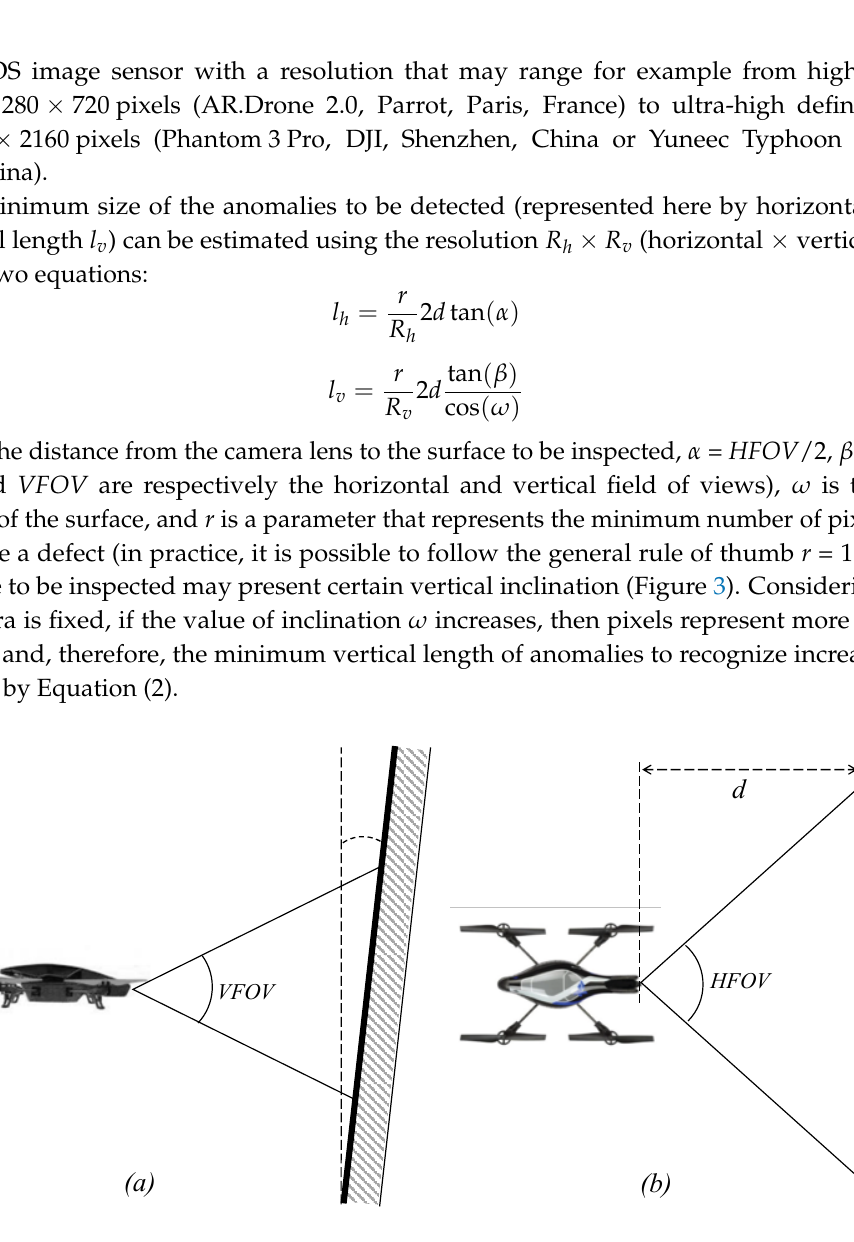
Figure 3. Location of the air vehicle with respect to the surface. The figure shows the vertical field of view VFOV of the camera ( a ), the horizontal field of view HFOV ( b ), vertical surface inclination ω and distance of the surface d .